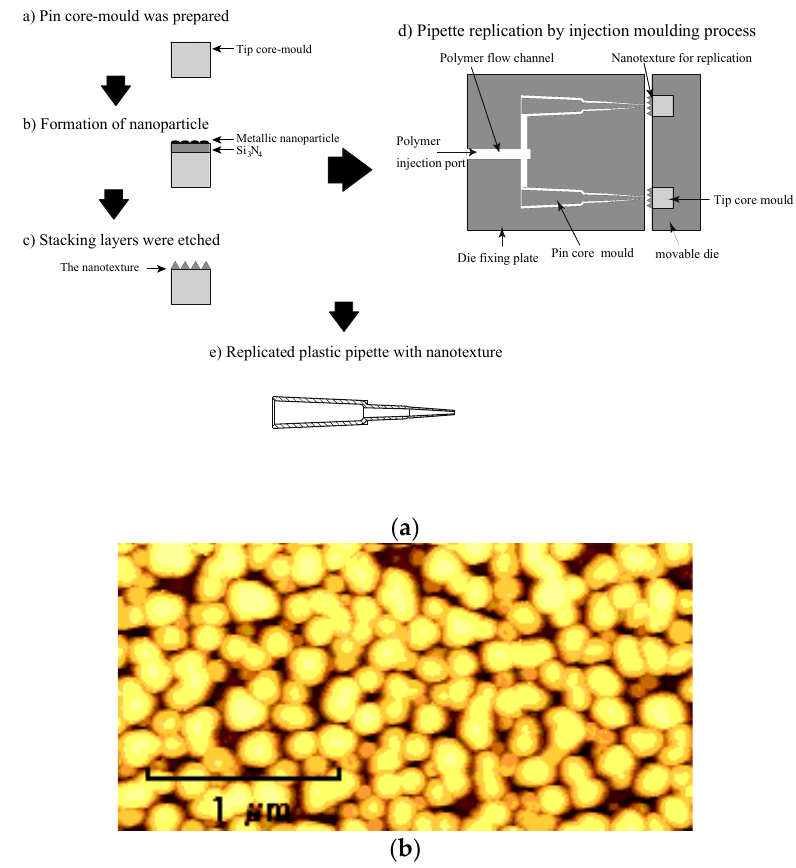
Figure 4. Illustration of the fabrication process of the nanostructured plastic capillary tube by injection moulding. ( a ) Fabrication process of the plastic pipette with nanotexture and ( b ) AFM image of the fabricated nanotexture.